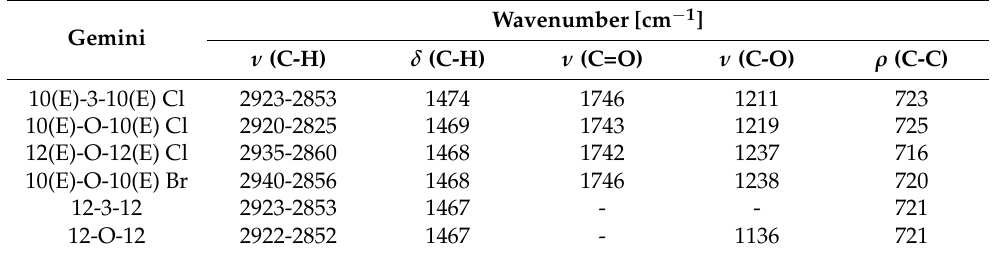
Table 1. Characteristic FTIR absorption bands for synthesized gemini surfactants.